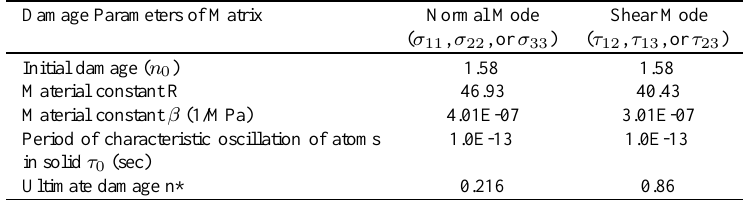
Table 2 List of Parameters Used in Damage Characterization of Matrix